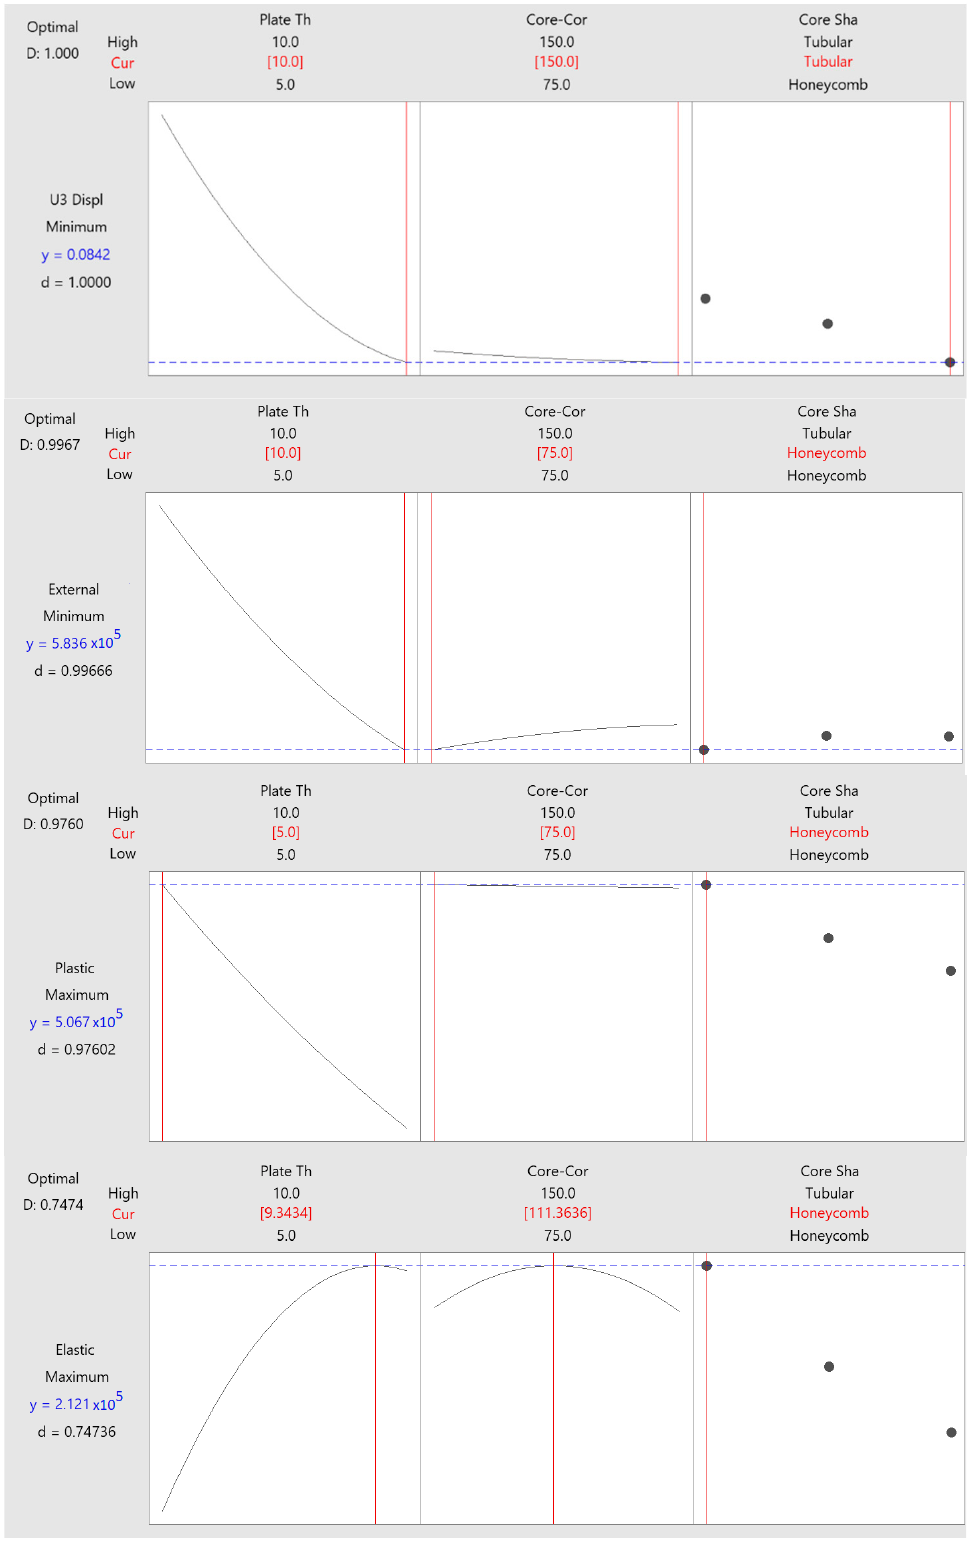
Figure 27. Optimal process parameters.